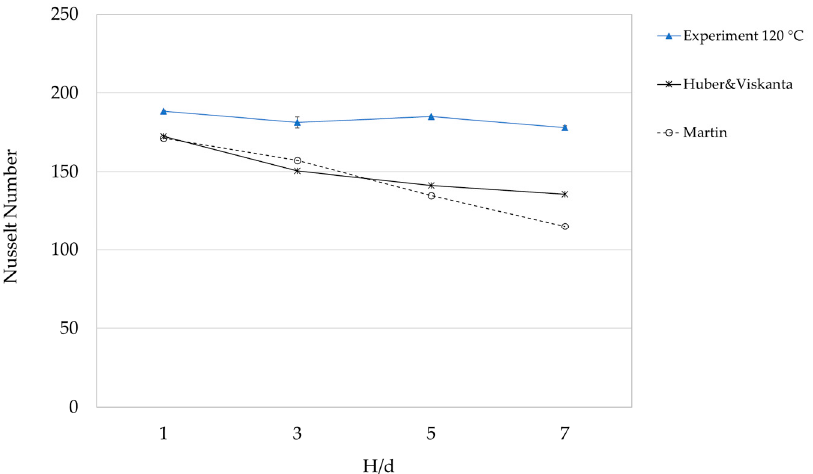
Figure 4. Effect of H / d on Nusselt number at a steam temperature of 120 ◦ C. We also show the impingement correlations by Huber and Viskanta and by Martin. Table 4. The correlations of the Nusselt number as a function of H / d , Nu = c 2 (H/d) n . The Correlations